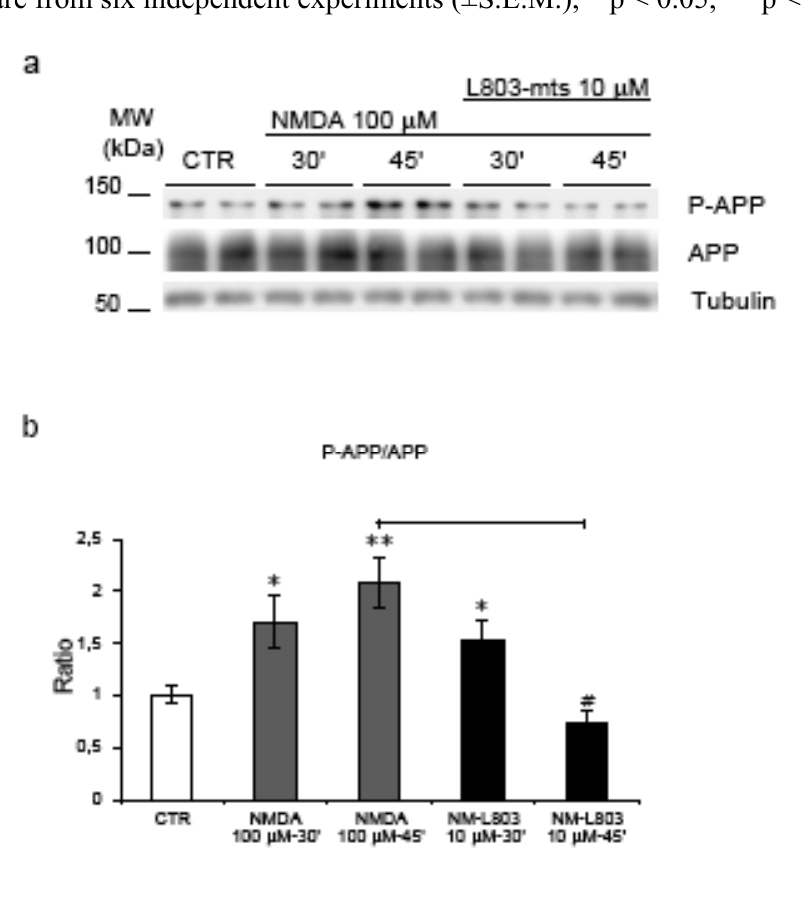
Figure 7. L803-mts action on APP phosphorylation. (a) Neurons were pre-treated with L803- mts and then exposed to NMDA (30’-45’). Western blot analysis shows that L803- mts/NMDA co-treatment inverts the increase of P-APP/APP ratio following NMDA administration. (b) Quantification revealed a significant reduction (65%) of P-APP in L803- mts/NMDA-45’ neurons compared to NMDA-45’(#=p < 0.05). Loading control: Tubulin. Quantifications are from six independent experiments (±S.E.M.), * p < 0.05, ** p <